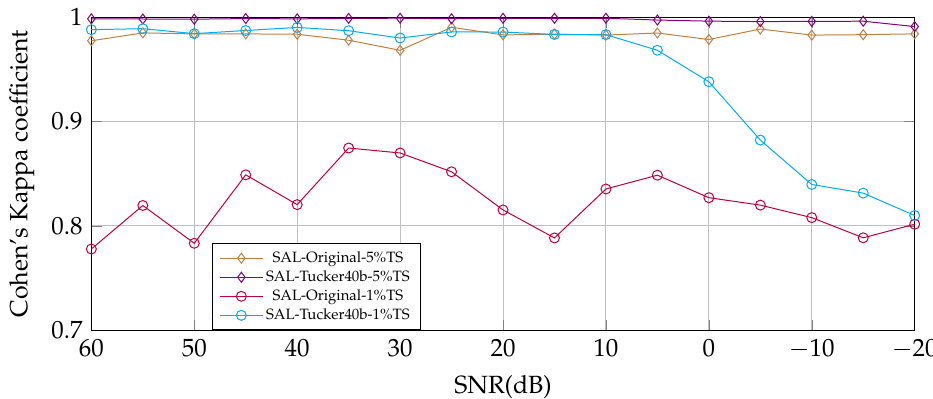
Figure 16. Salinas. Cohen’s Kappa coefficient obtained using the 3DCNN DL model trained for 40 epochs from the original SAL HSI and compressed with TKD to 40 tensorial bands. From 60 to − 20 dB, Tucker improved the performance for Cohen’s Kappa coefficient.